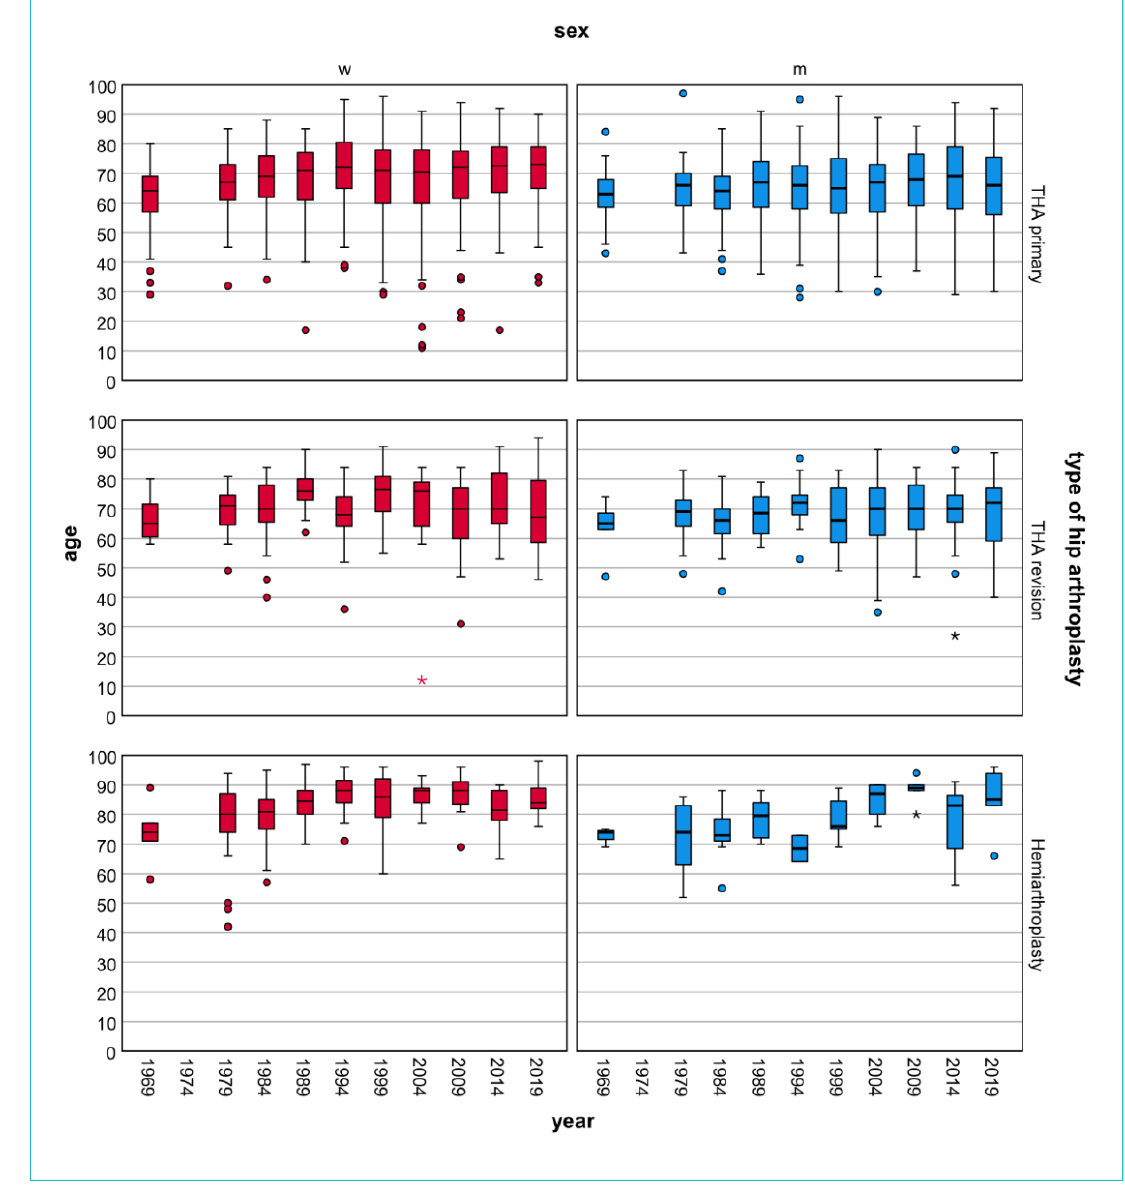
Figure 2: Age of patients according to type of hip arthroplasty and gender from 1969 to 2019 at 5-year